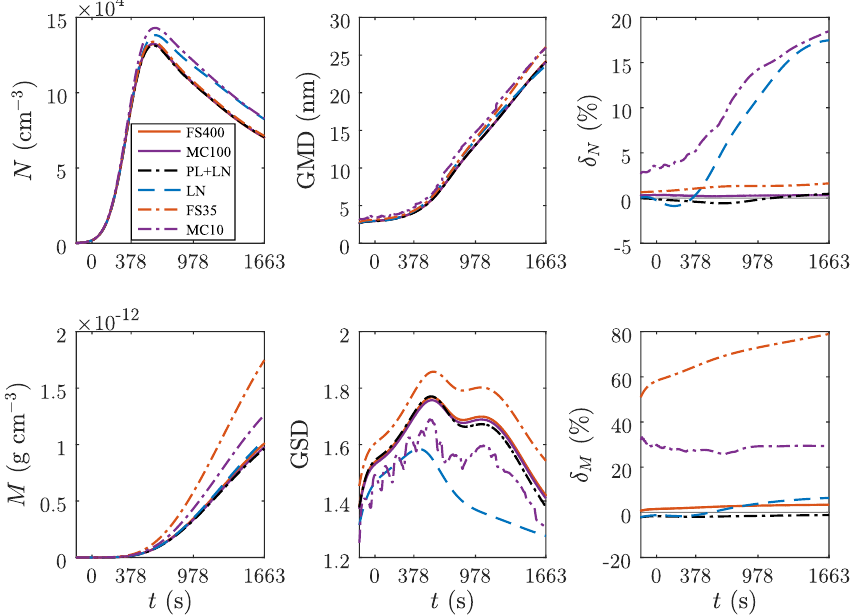
Figure 13. Number ( N ) and mass ( M ) concentrations, GMD, and GSD of the nucleation mode and the relative errors of the concentrations ( δ N and δ M ) in the chamber event, produced by different models. The outputs of the FS400 and the MC100 models are nearly equal, and thus they are difficult to distinguish in the